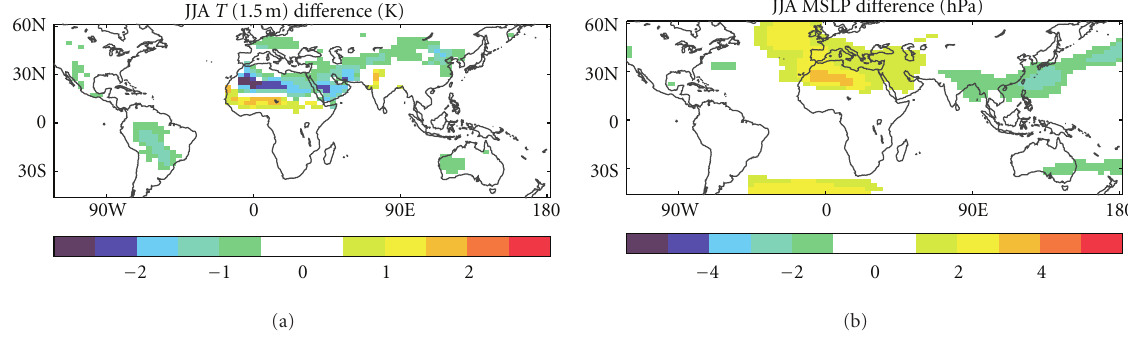
Figure 8: The di ff erence in JJA (a) surface air temperature at 1.5 m (K) and (b) mean sea level pressure (MSLP, hPa)) for DEAD relative to CLIM.